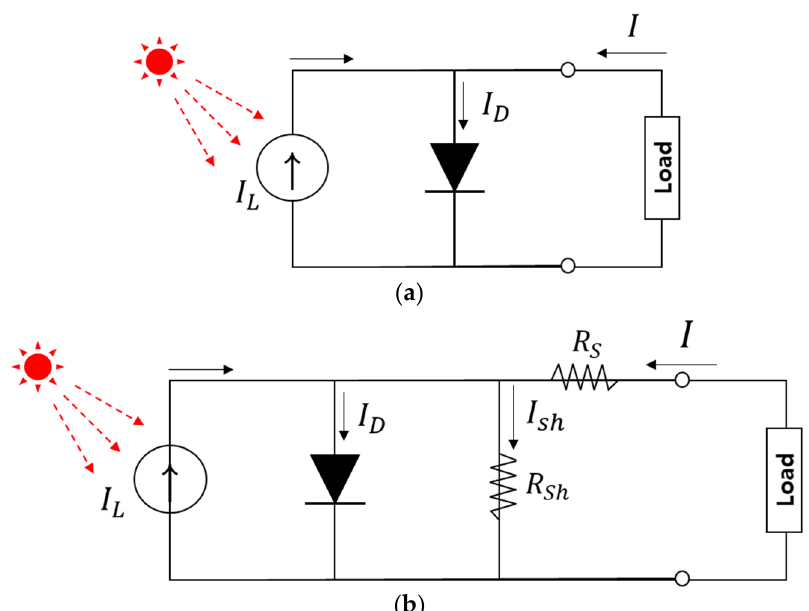
Figure 2. Equivalent electrical circuit of ( a ) an ideal solar cell and ( b ) an actual solar cell.